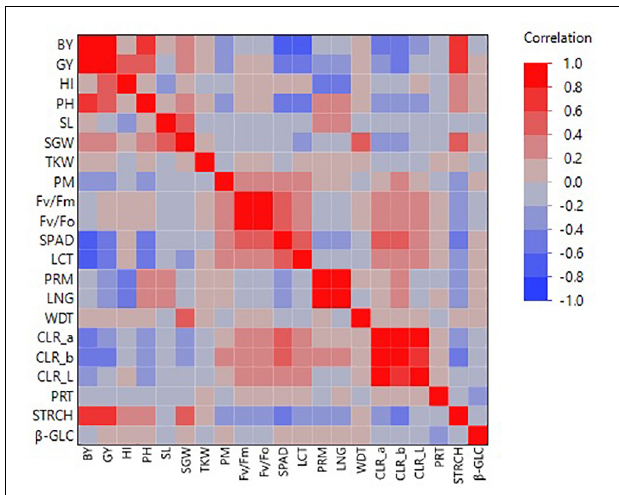
FIGURE 6 | Colour map on pairwise correlations for the different traits recorded during the evaluation of the barley lines in the distinct environments in